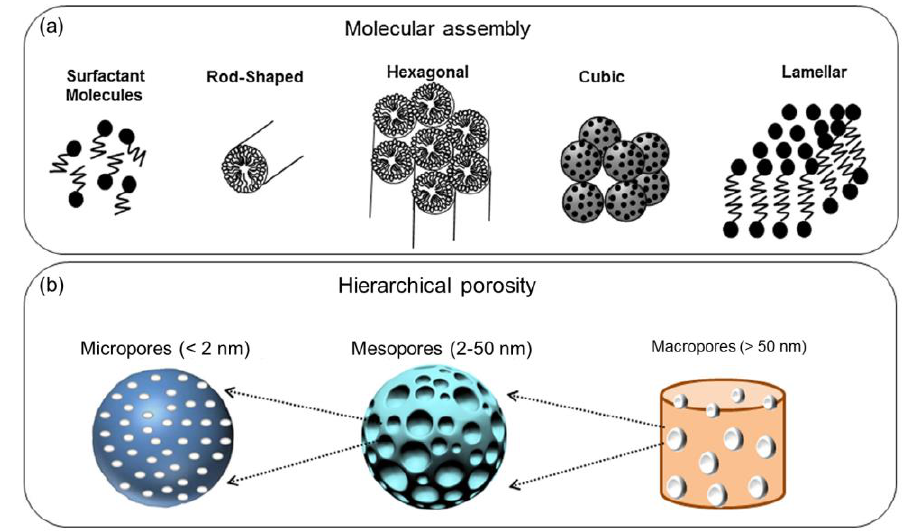
Figure 1. Basic concepts related to mesoporous materials: ( a ) molecular self-assembling of surfactant micelles to originate mesopores and ( b ) pore size scales according to IUPAC terminology. Images adapted from Owens et al. [15] ©